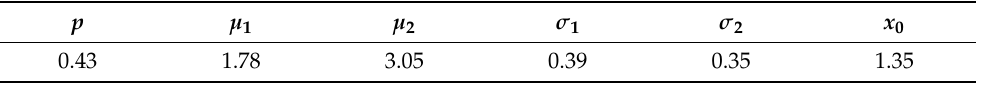
Table 2. Values of the parameters of the theoretical probability function fitted in this work (Equation (1)). The meaning of each of the abbreviations can be found in the main text. Table 3. Statistical variables for theoretical probability distribution, fitted as a bimodal lognormal function. Statistical variables